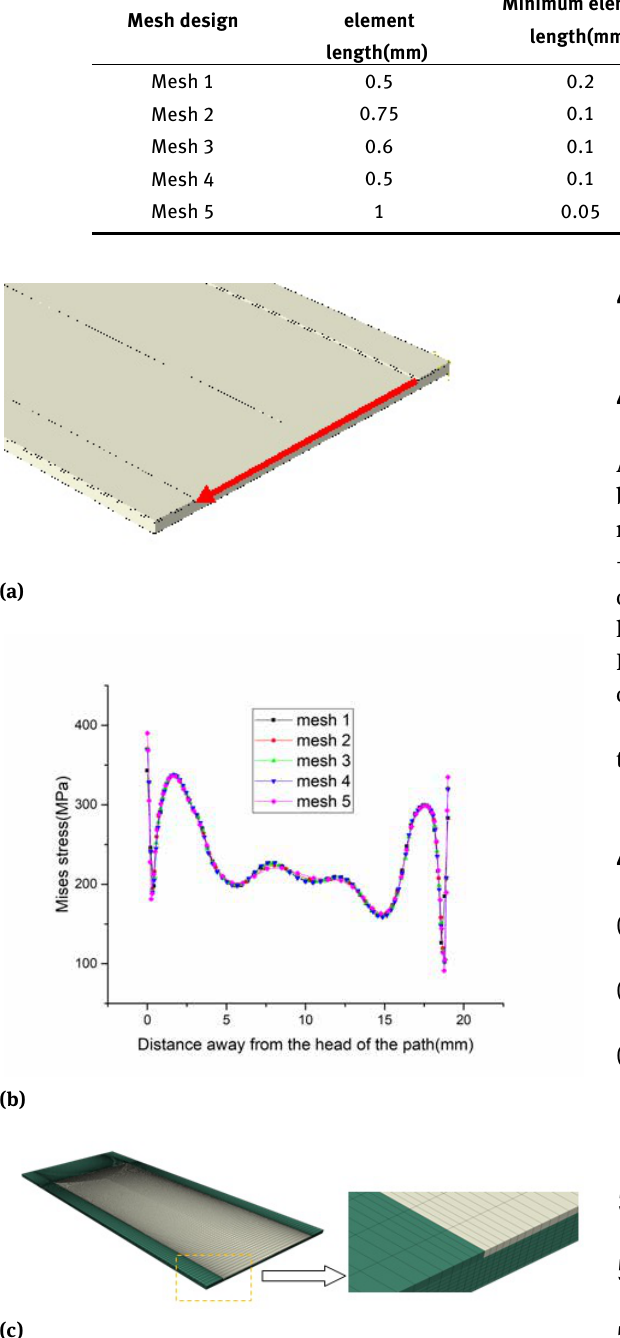
Figure 3: a) The output path; b) Mises stress results along the path and (c) Mesh grids used in the